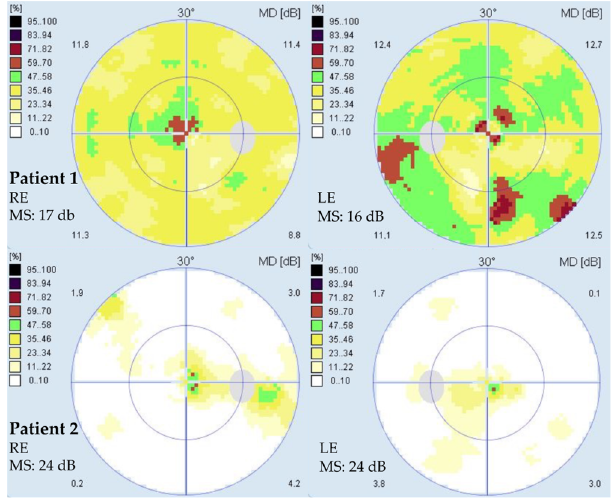
Figure 3. Visual field (Octopus G2 top) of Patient 1 (upper row) and Patient 2 (bottom row) at the last visit at the ages 37 and 63 years, respectively. Note the reduced central sensitivity in both patients, more pronounced in Patient 1. A color-coded sensitivity scale is shown on the left. Abbreviations: RE—right eye; LE—left eye; MS—mean sensitivity.